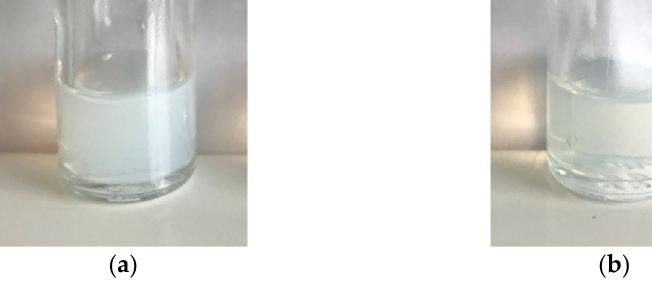
Figure 3. Macroscopic observation of Blank-NEs ( a ) and Tg-NEs ( b ). Table 4. Physicochemical characteristics of nanoemulsions ( n ≥